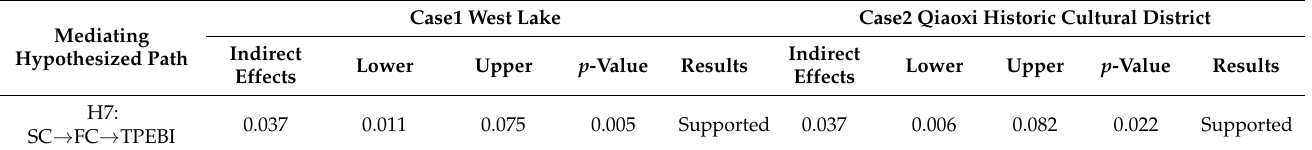
Table 5. Mediation test results.